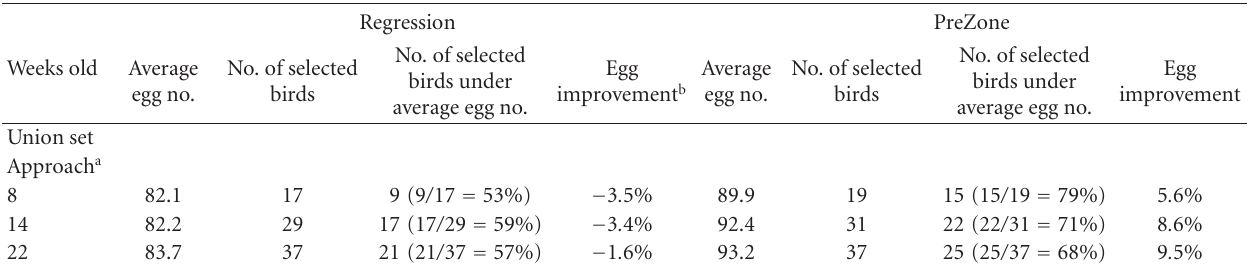
Table 10: Selection of low egg productivity in batch C of birds using union set of batches A and B